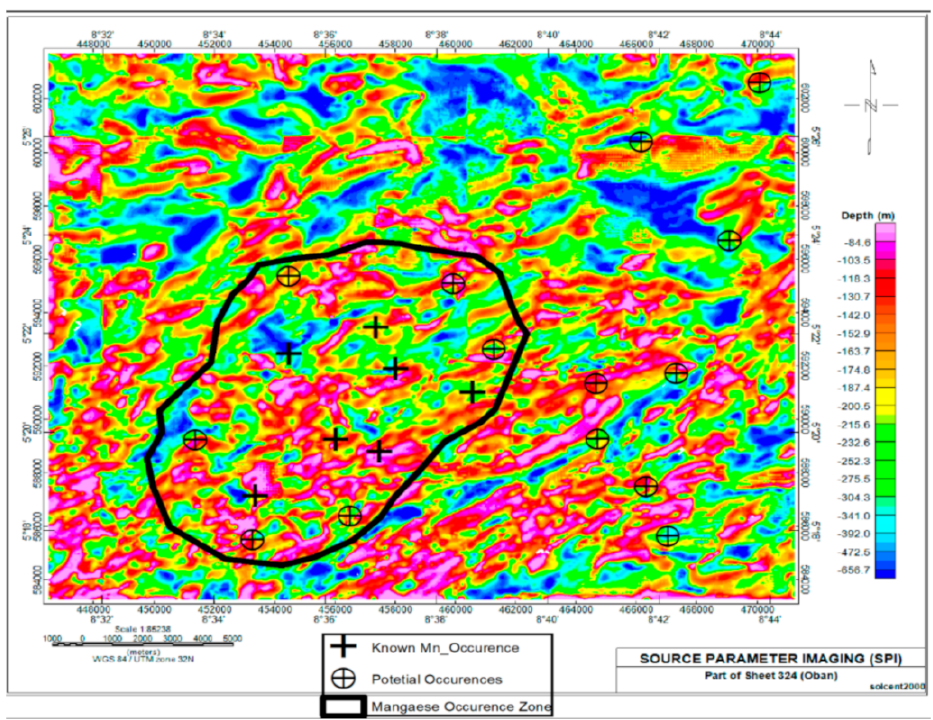
Figure 15. Source parameter imaging map with known and potential occurrence zones in the study area.